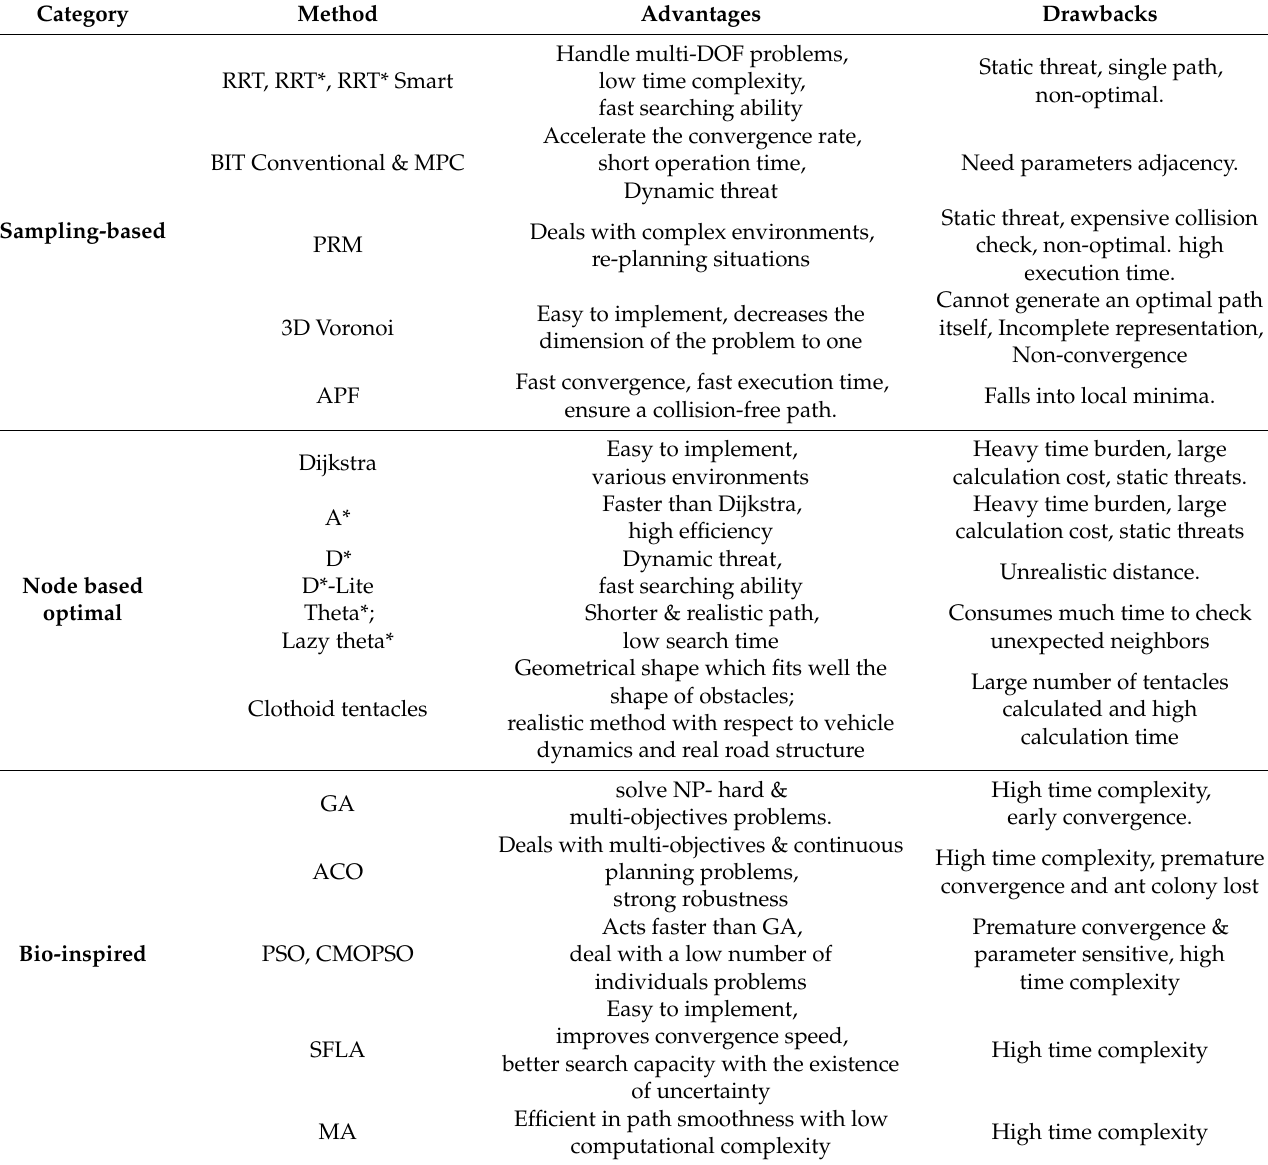
Table 1. Analysis of path planning